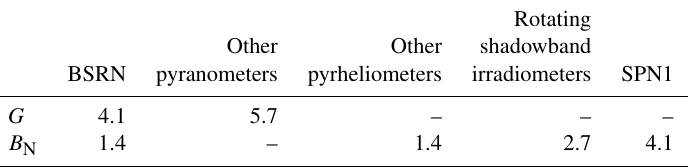
Table 5. Expectations for the relative standard deviation of errors σ